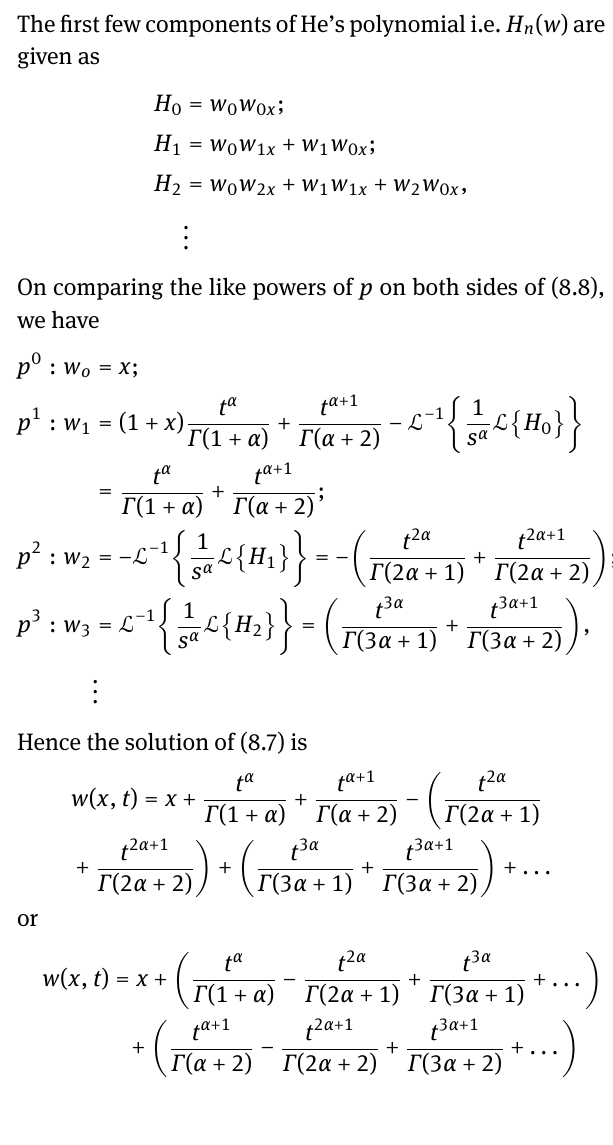
The first few components of He’s polynomial i.e. H